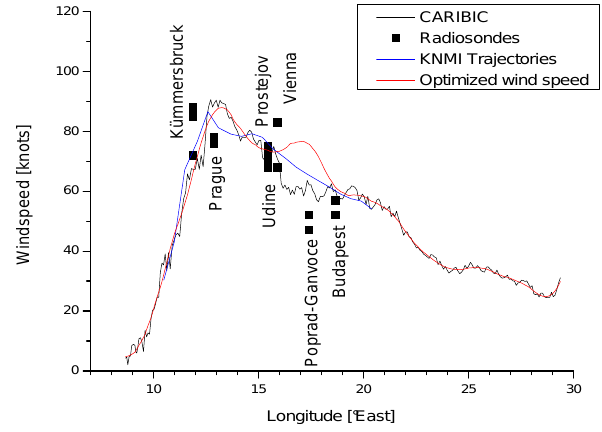
Fig. 11. Wind speed on 15 August 2008 observed by CARIBIC and by radio soundings with a maximum distance to the flight track of 300km along the wind direction. In addition the ECMWF winds speed (from the trajectory model output) and the optimized wind speed used for further analysis are shown. Only at Prague and K¨ummersbruck soundings were performed at 06:00UTC, for the other stations both 00:00 and 12:00UTC are depicted. As the plane was descending to Frankfurt, different measurements for different altitudes are shown in K¨ummersbruck. The one closest to the flight altitude fits best, the other two are more related to the plume altitude of 11.5 ± 0.5km but are similar to the CARIBIC data at